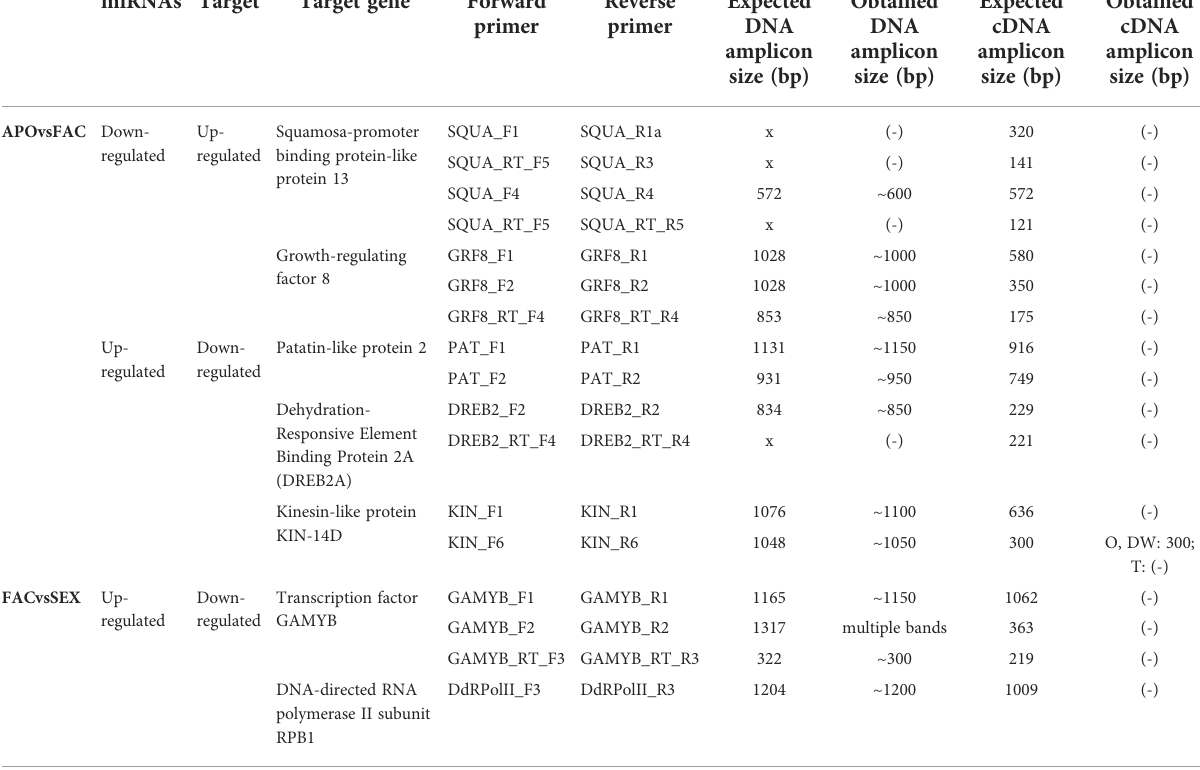
TABLE 5 PCR amplicons expected and predicted sizes obtained from DNA and cDNA with several combinations of transcript-based